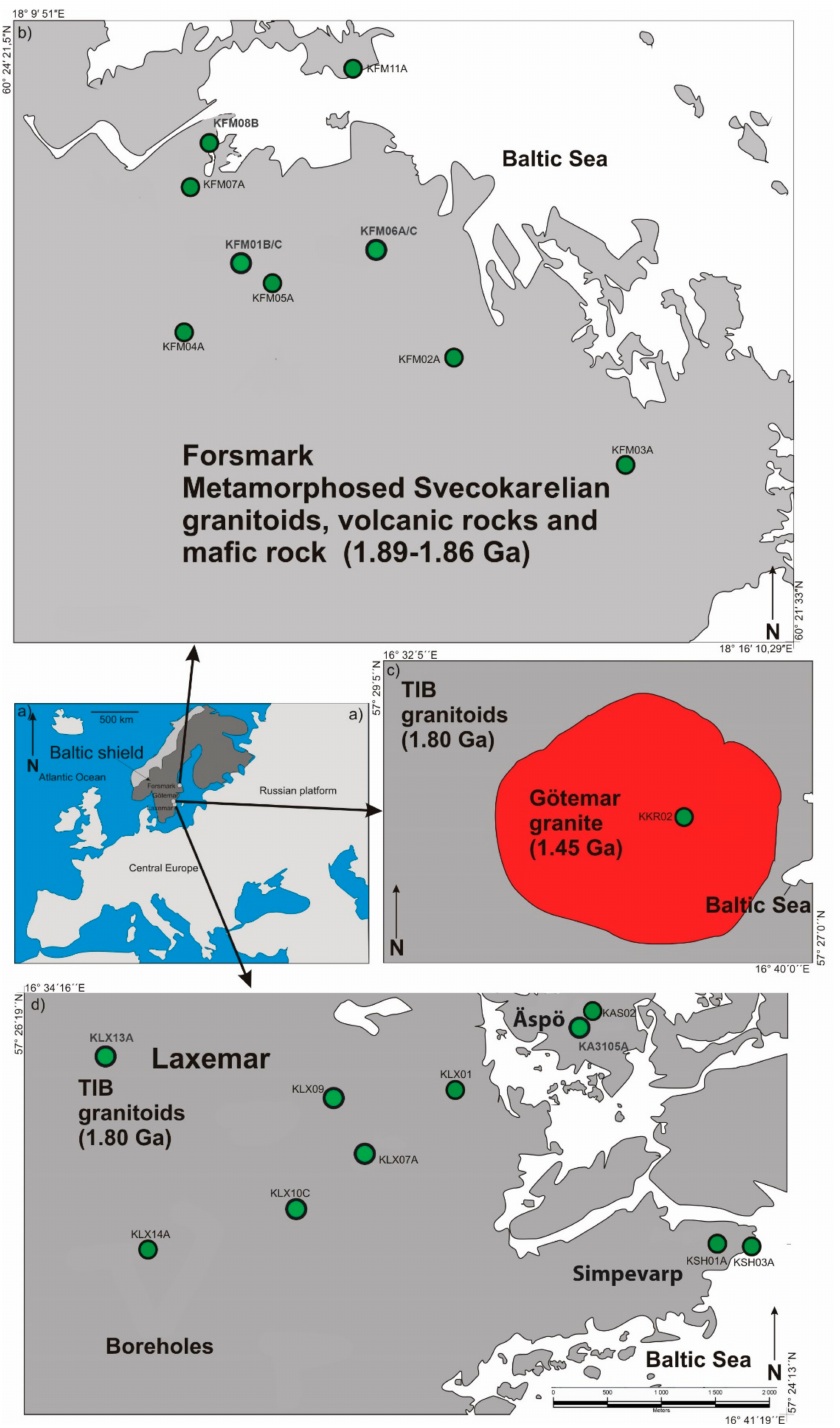
Figure 1. Map of the Baltic shield ( a ) with study sites Forsmark ( b ), Götemar ( c ), here included as a sub-area to Laxemar-Äspö), ( d ) Laxemar-Äspö, indicated. Sampled cored boreholes are indicated. Modified from Drake et al., 2017 [34], reprinted with permission (#4900621281616) from